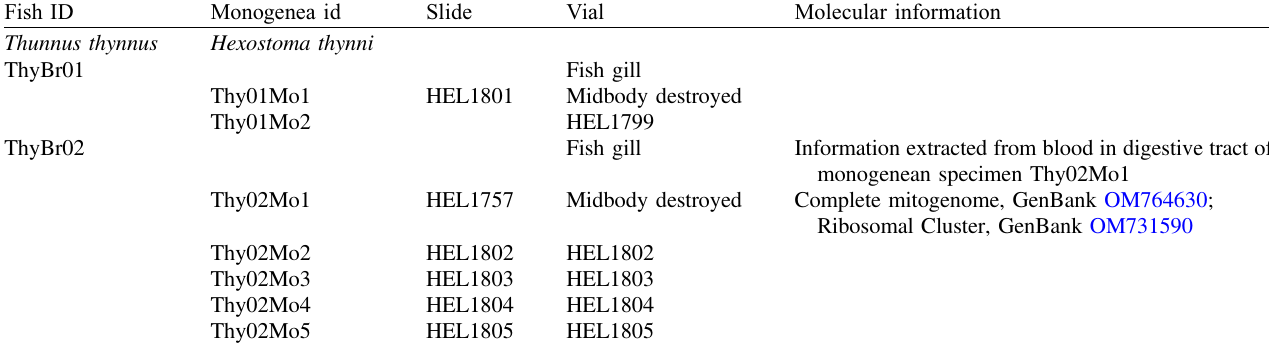
Table 1. Specimens of Hexostoma thynni : vouchers for molecular studies. Monogeneans were collected from two fi sh specimens. Fish ThyBr01 provided two monogenean specimens. Fish ThyBr02 provided fi ve monogenean specimens. For each monogenean specimen, the slide includes the anterior and posterior extremity (stained and mounted in Canada balsam) and the vial contains the midbody. In addition, 10 whole monogenean specimens were mounted on permanent slides and are deposited as MNHN HEL1806 –